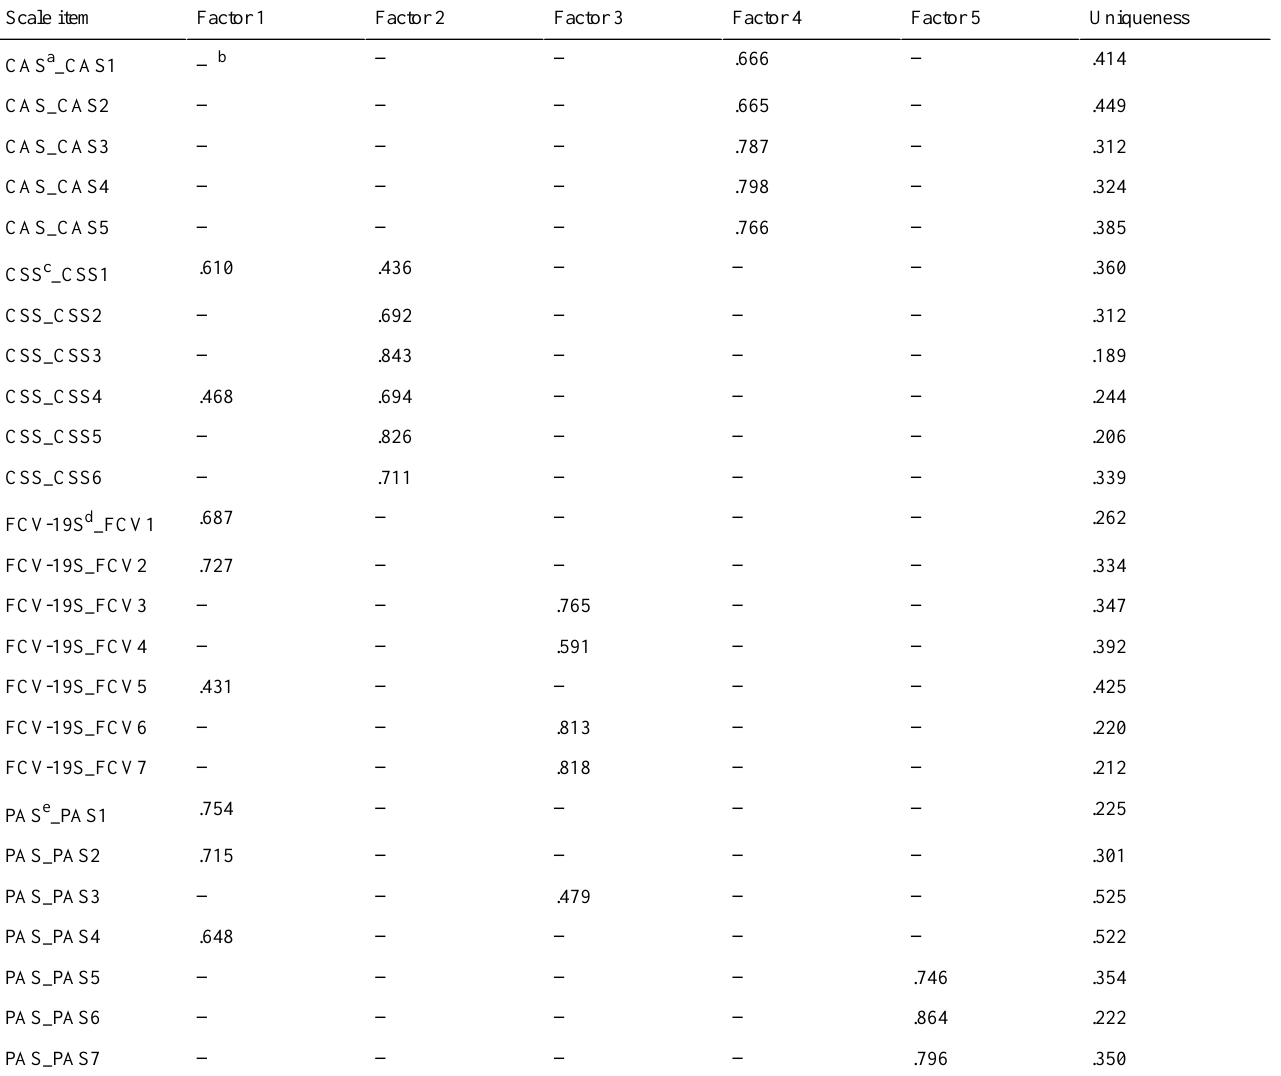
Table 5. Exploratory factor analysis of the CAS, CSS, FCV-19S, and PAS scales. The varimax rotation method was applied.